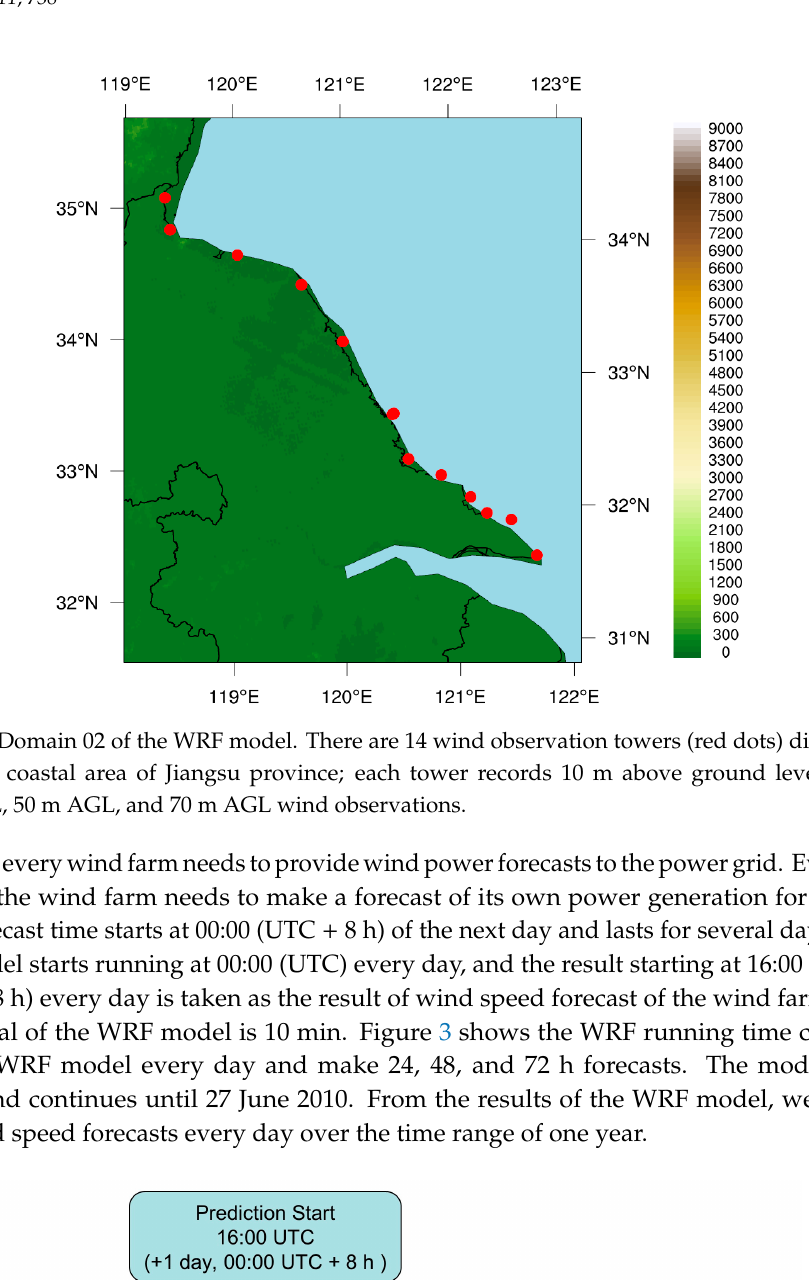
Figure 3. WRF model running time for the wind power forecasting of wind farms in China.